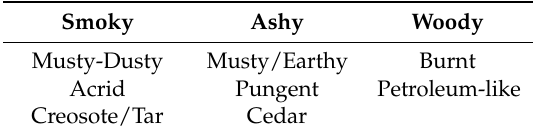
Table 1. List of sensory attributes imparting smoked aroma characteristics